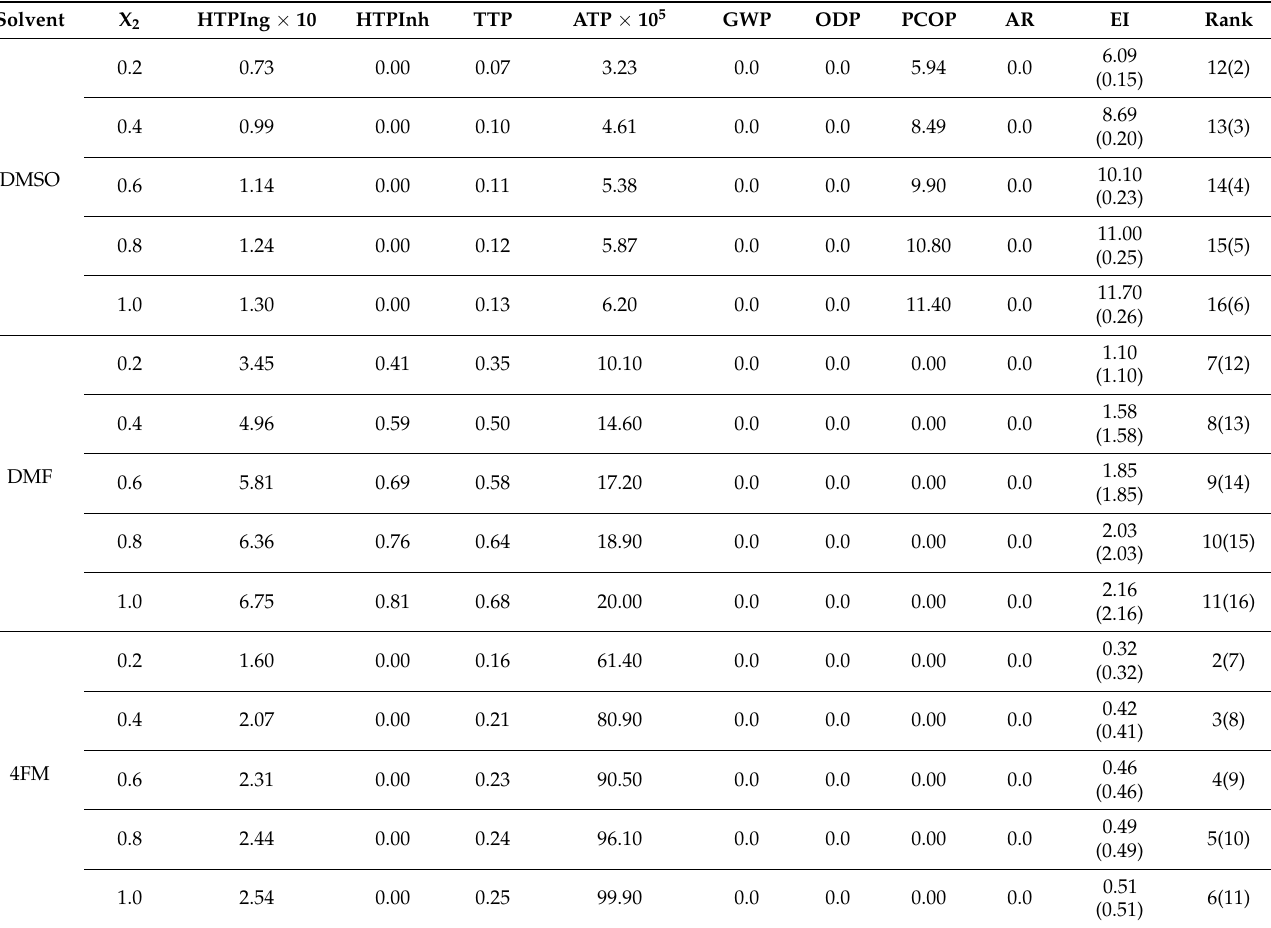
Table 2. The ranking of environmental friendliness of considered aqueous-organic solvents according to PARIS III tool [146–150]. The default impact factor, namely 5 was applied. The x 2 symbol denotes the organic component molar fraction in the binary mixture. In the parentheses, the values calculated without including the PCOP parameter were